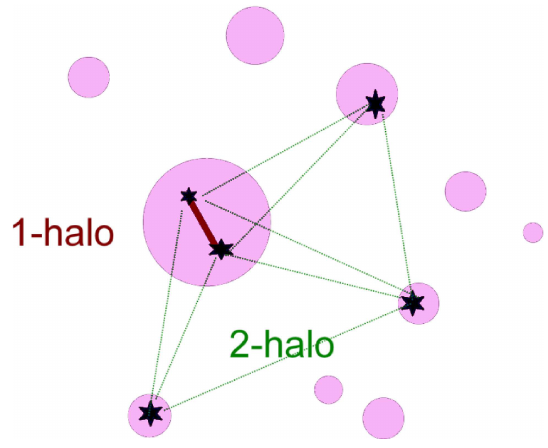
Figure 2: In the conceptual model of the HOD ap- proach, there are two contributions to the pairs that account for the measured correlation function. Pairs of objects (black stars) can either be located within the same DMH (pink filled circles), such that their mea- sured separation contributes to the 1-halo term (red solid line in the large DMH), or can reside in different DMHs, such that their separations (green dotted line) contribute to the 2-halo